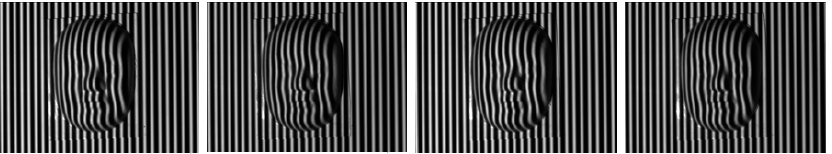
Figure 8. A fringe pattern from the mask experiment and its corresponding phase-shifting fringe patterns.